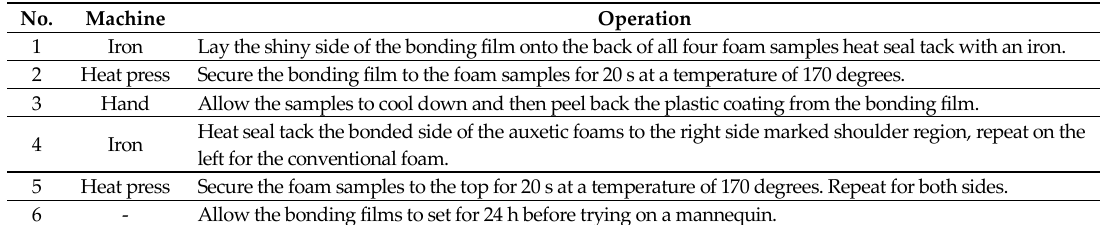
Table 1. Construction method.